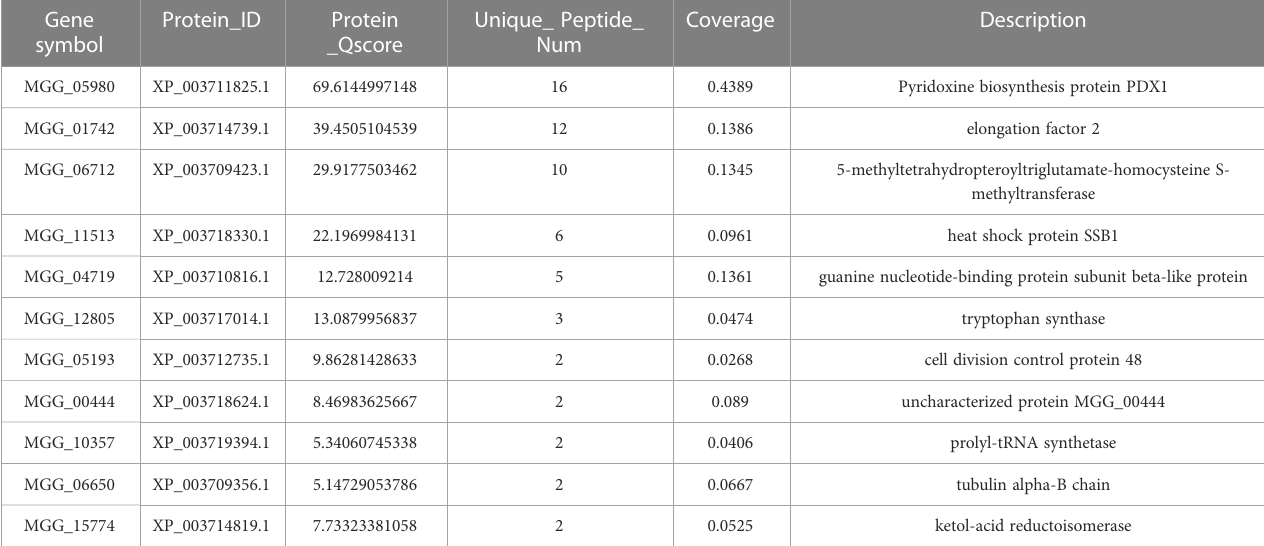
TABLE 3 Co-IP assays identi fi ed more than two peptides that potentially interacted with the MoPdx1 protein in both two MoPdx1-GFP expressing strains, except the proteins in only GFP expressing strains. Gene Protein_ID Protein Unique_ Peptide_ symbol _Qscore